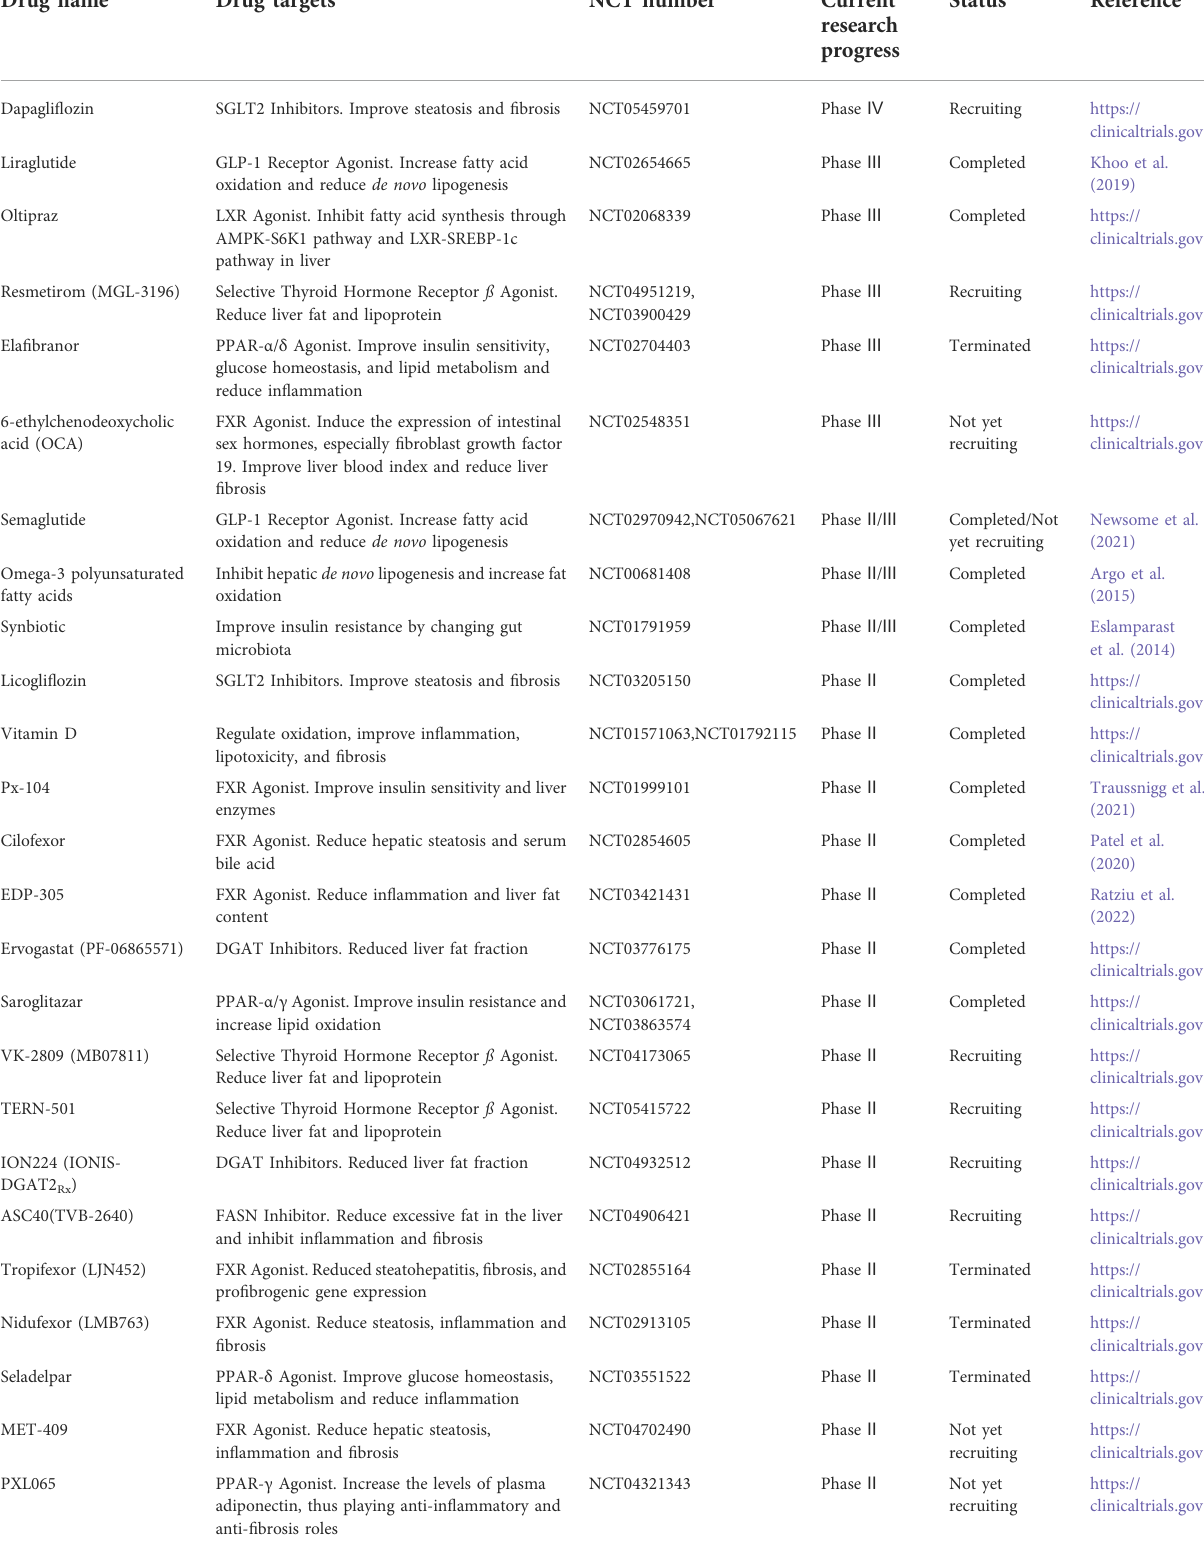
TABLE 1 Mechanism and Research Progress of drugs targeting carbohydrate and lipid